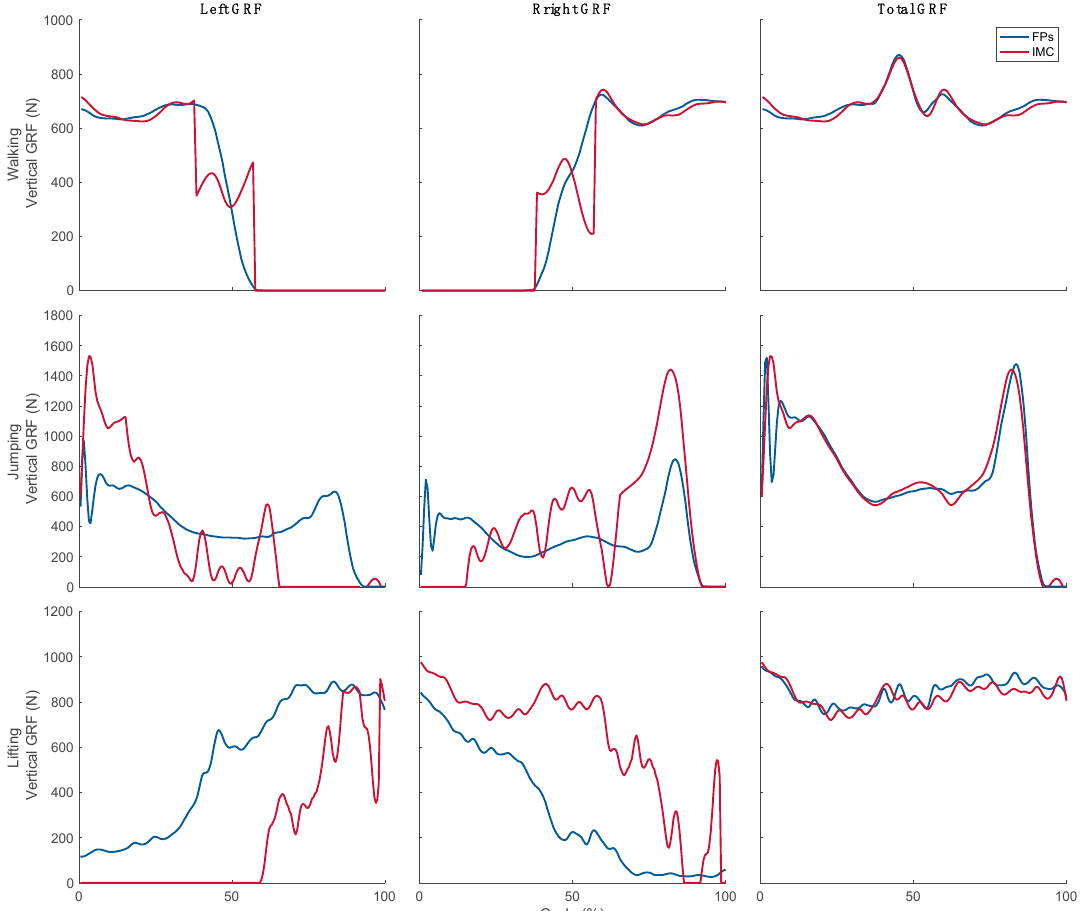
Figure 7. Typical examples of the FP measured (blue line) and IMC predicted (red line) vertical components of the left, right, and total GRFs during walking, jumping, and lifting.